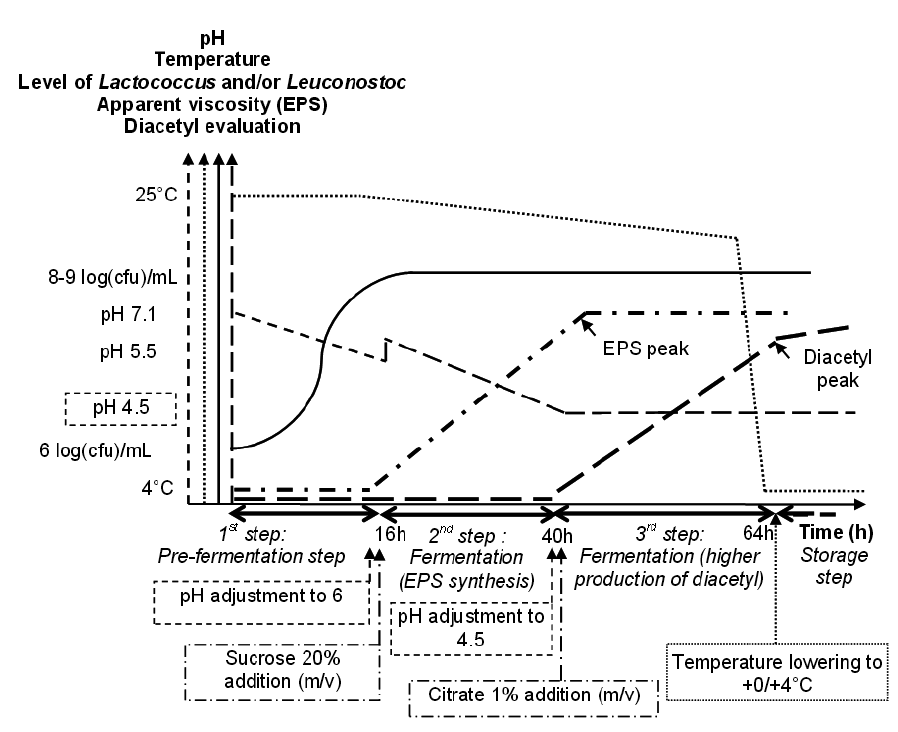
Fig. 1. Monitoring of the pre-fermentation, sucrose and citrate fermentation steps for EPS and diacetyl production by respectively EPS positive Leuconostoc strain (P35) and citrate positive Lactococcus strain (F2.3). The actions written in boxes were those performed to guide the fermentation process. Legend: pH, temperature (°C), level of Lactococcus (log(cfu)/mL) , Apparent viscosity (EPS) and diacetyl